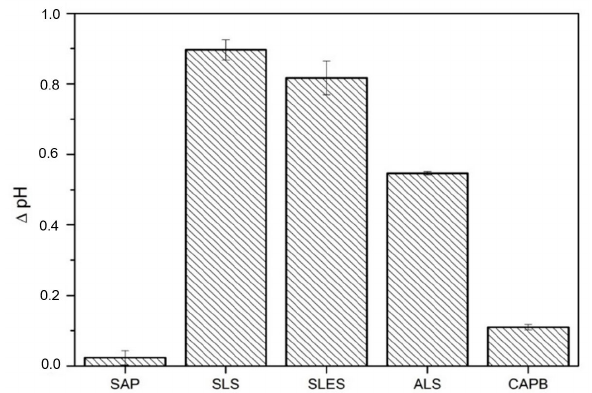
Figure 6. pH increases in BSA solution ( ∆ pH) incubated with the soapwort extract (SAP) or synthetic surfactants (SLS, SLES, ALS, CAPB), 5% concentration of the dry weight, after 2 h incubation with albumin at room